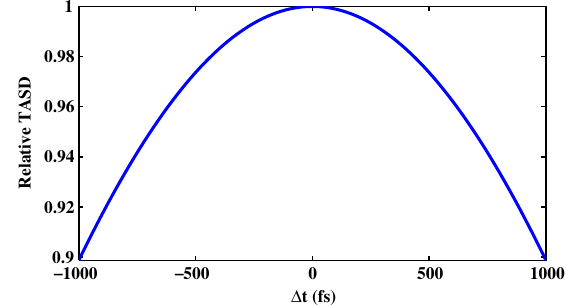
FIG. 10. Relative TASD as a function of synchronization delay between laser and electron pulses. Note that the function is Gaussian.